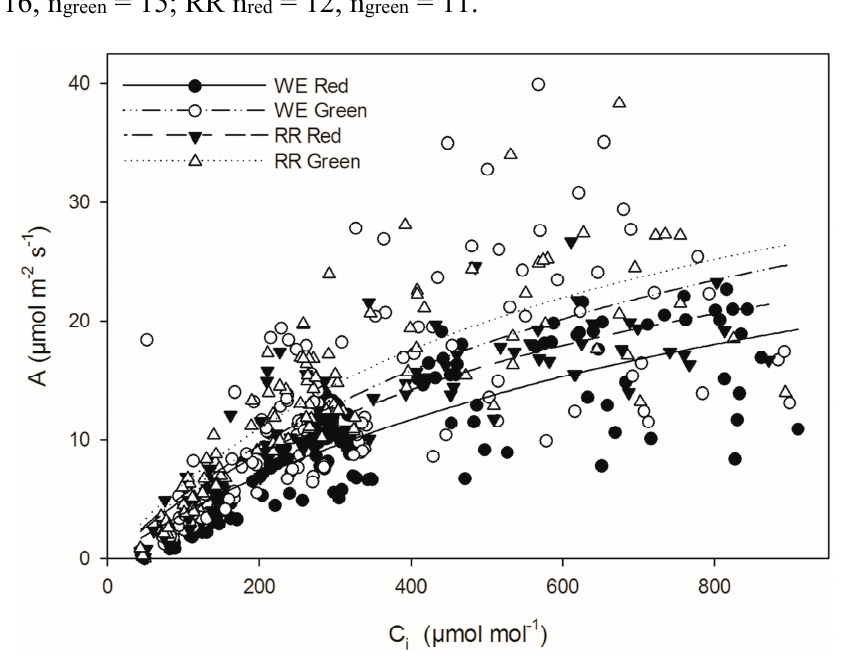
Figure 5. Photosynthesis (A) versus internal CO 2 concentrations (C i ) for red (solid symbols) versus green (open symbols) leaves at WE (circles) and RR (triangles). WE n red = 16, n green = 15; RR n red = 12, n green = 11.